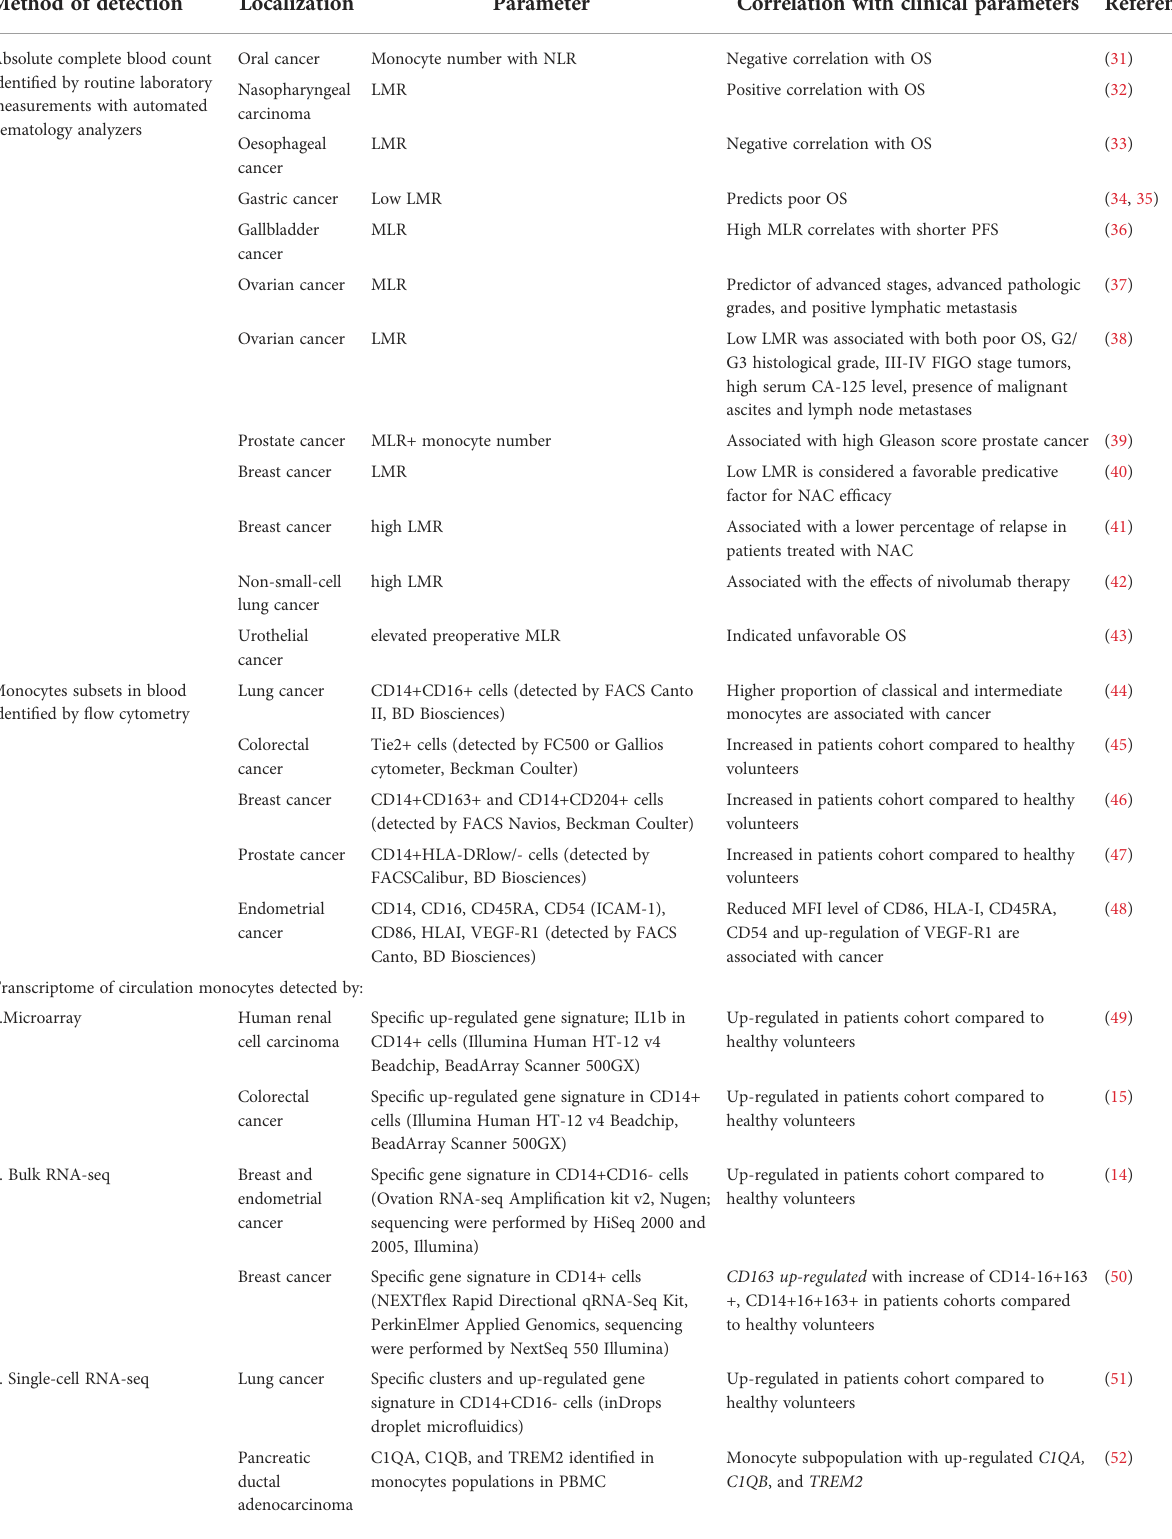
TABLE 1 Clinical analysis of circulation monocyte diversity in